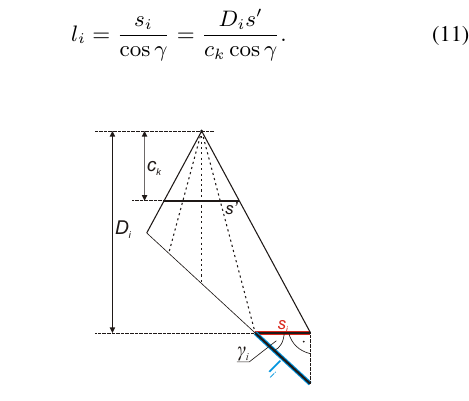
Figure 3: Simplified geometry for calculations of the resolution The difference between the three ways to calulate l i (6, 10 and 11) is not significant. Only for very large γ the difference in l i cal- culated using these three equation is remarkable. However, such textures, where γ is very large are not useful at all and should not be used for texture mapping. Thus, in practice, the simplest (11) can be used. D i is given by the depth image, while c k - camera constant and s (cid:48) - pixel size comes from the camera